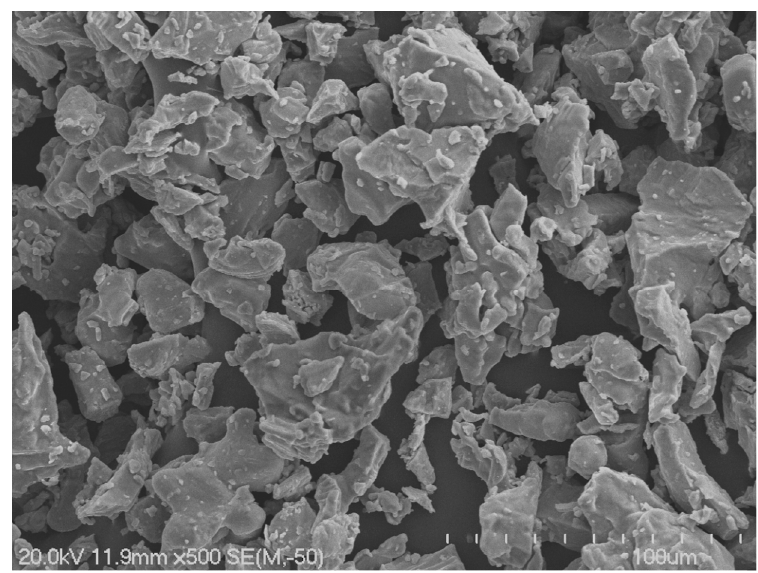
Figure 2. SEM image showing the particle morphology of the HDH titanium powders.